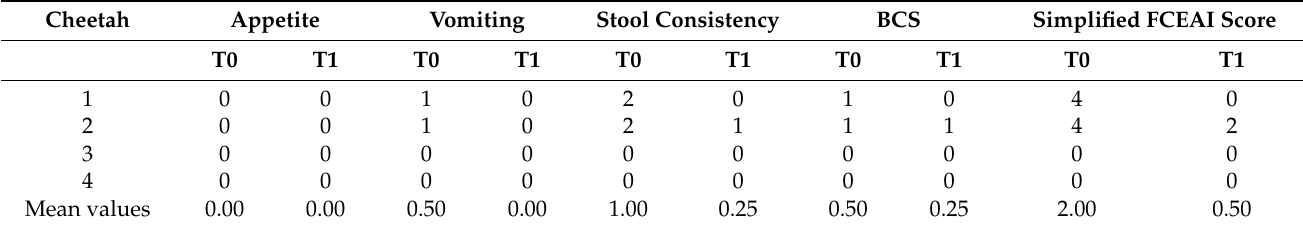
Table 2. Simplified FCEAI score in Group A at T0 and T1.